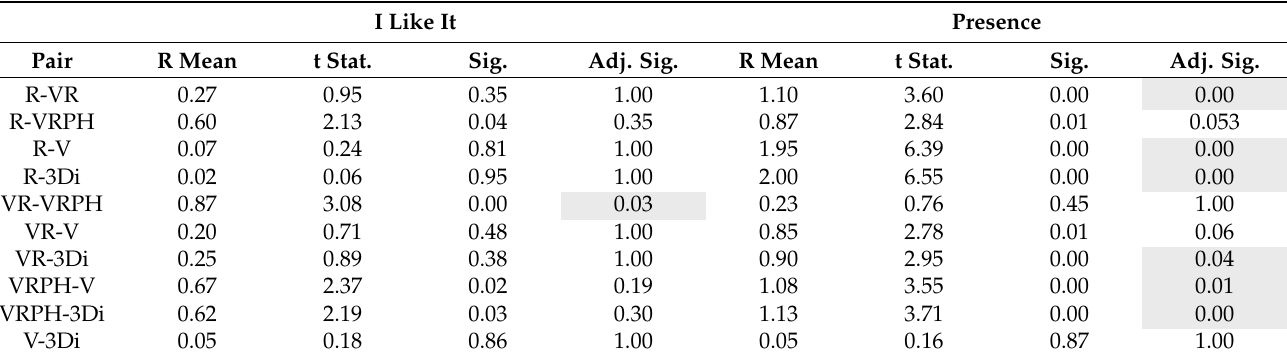
Table 6. Adjusted significance levels for the “I like it” question, sense of presence, and pairwise comparisons. Grey areas depict statistically significant